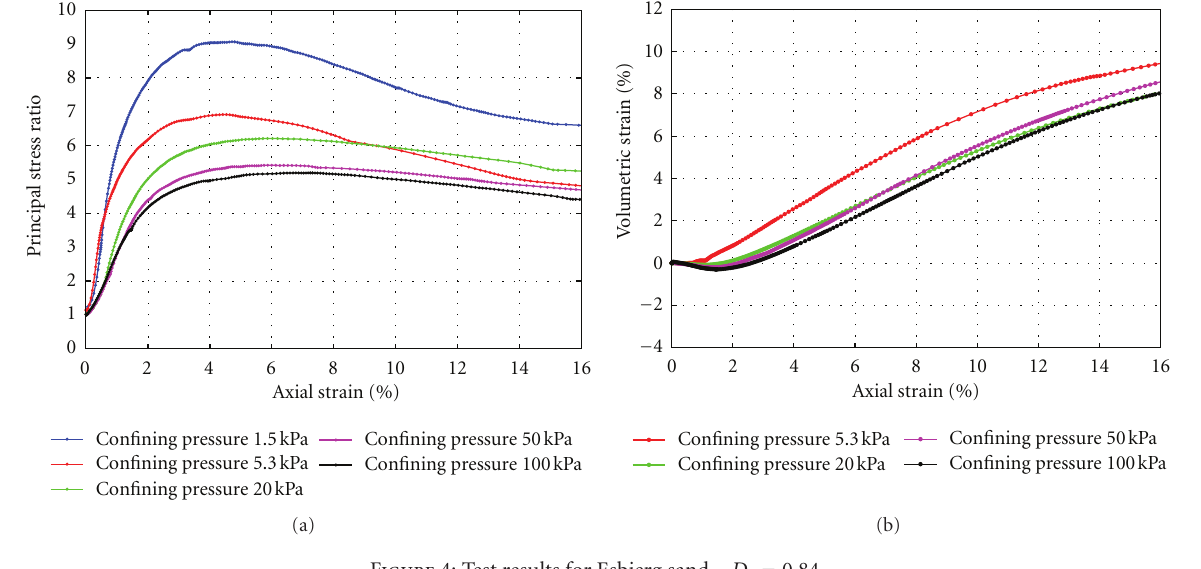
Figure 4: Test results for Esbjerg sand— D r = 0 . 84.